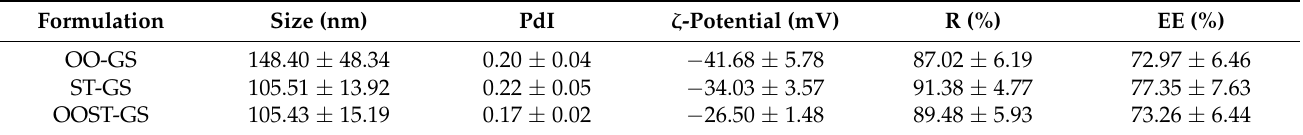
Table 3. Physical and chemical parameters of glycerosomes loaded with: O. onites essential oil (OO-GS), S. thymbra essential oil (ST-GS), O. onites plus S. thymbra essential oils (OOST-GS). From left: Size, polydispersity index (PdI), ζ -potential, recovery (R) and encapsulation efficiency (EE); mean ± SD ( n = 3). Formulation Size (nm) PdI ζ -Potential (mV) OO-GS 148.40 ± 48.34